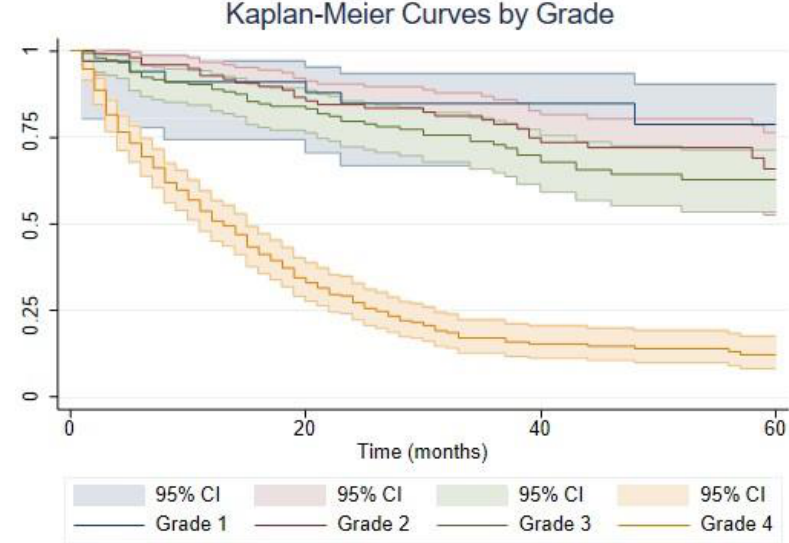
Figure 1. Kaplan–Meier plot by grades. CI-confidence interval. Figure 1. Kaplan – Meier plot by grades. CI-confidence interval. Table 2. Demographic and clinical characteristics of patients and their